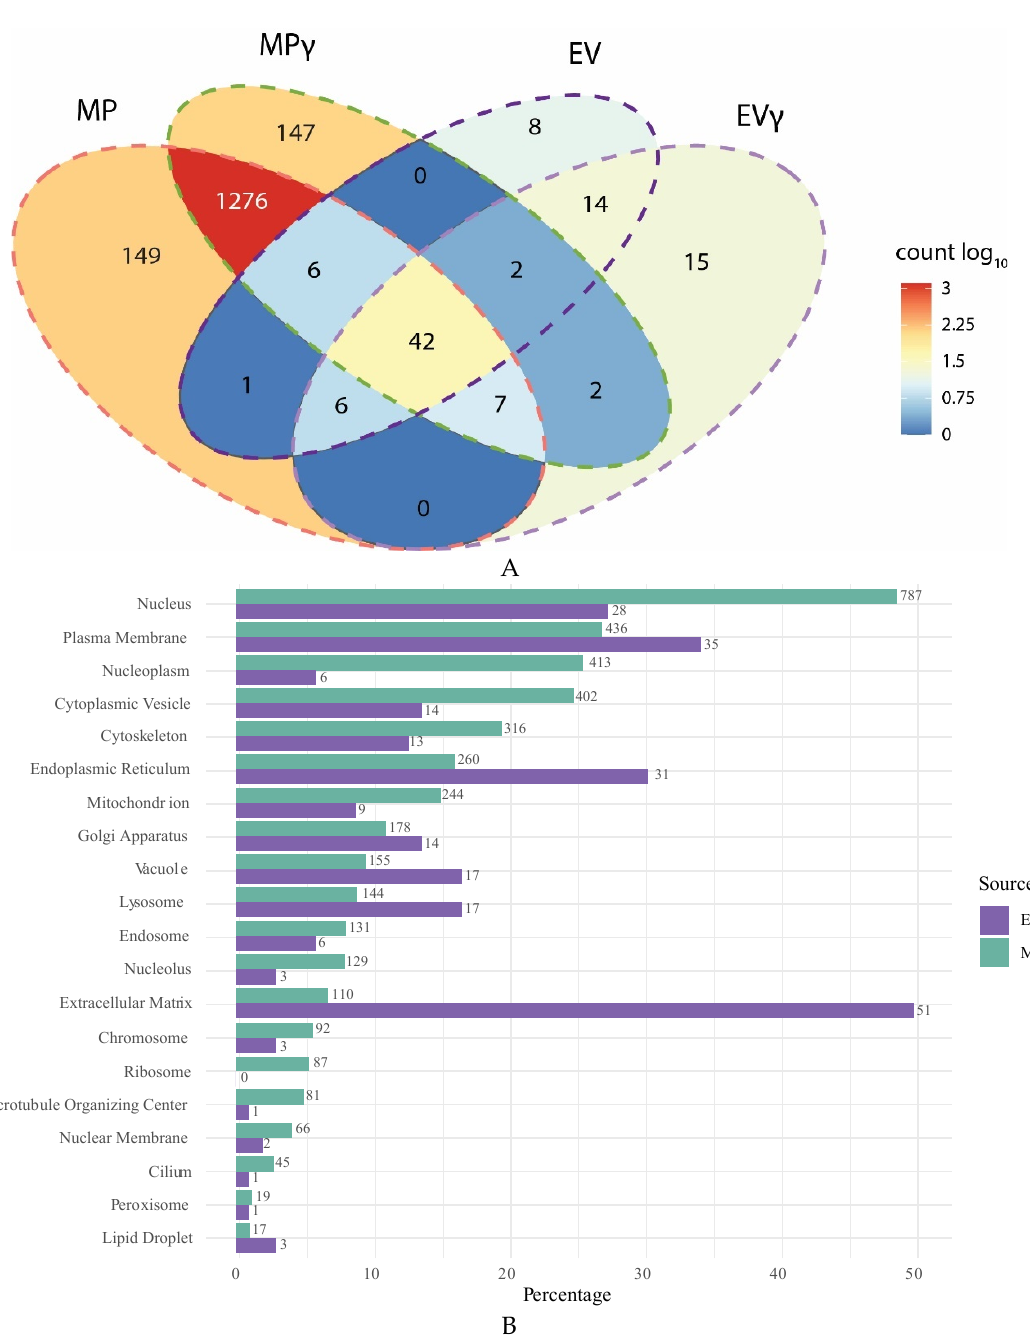
Figure 3. Proteomic comparison of EV, EV γ , MP and MP γ . ( A ): Venn chart showing the number of proteins expressed in EV, EV γ , MP and MP γ and overlap in expression between the different vesicle types. ( B ): Normalized comparison of the origin of EV and MP proteins. Bars depict the percentage of proteins associated with the indicated cellular compartment, numbers indicate the number of proteins that can be associated with the diverse cellular compartments.